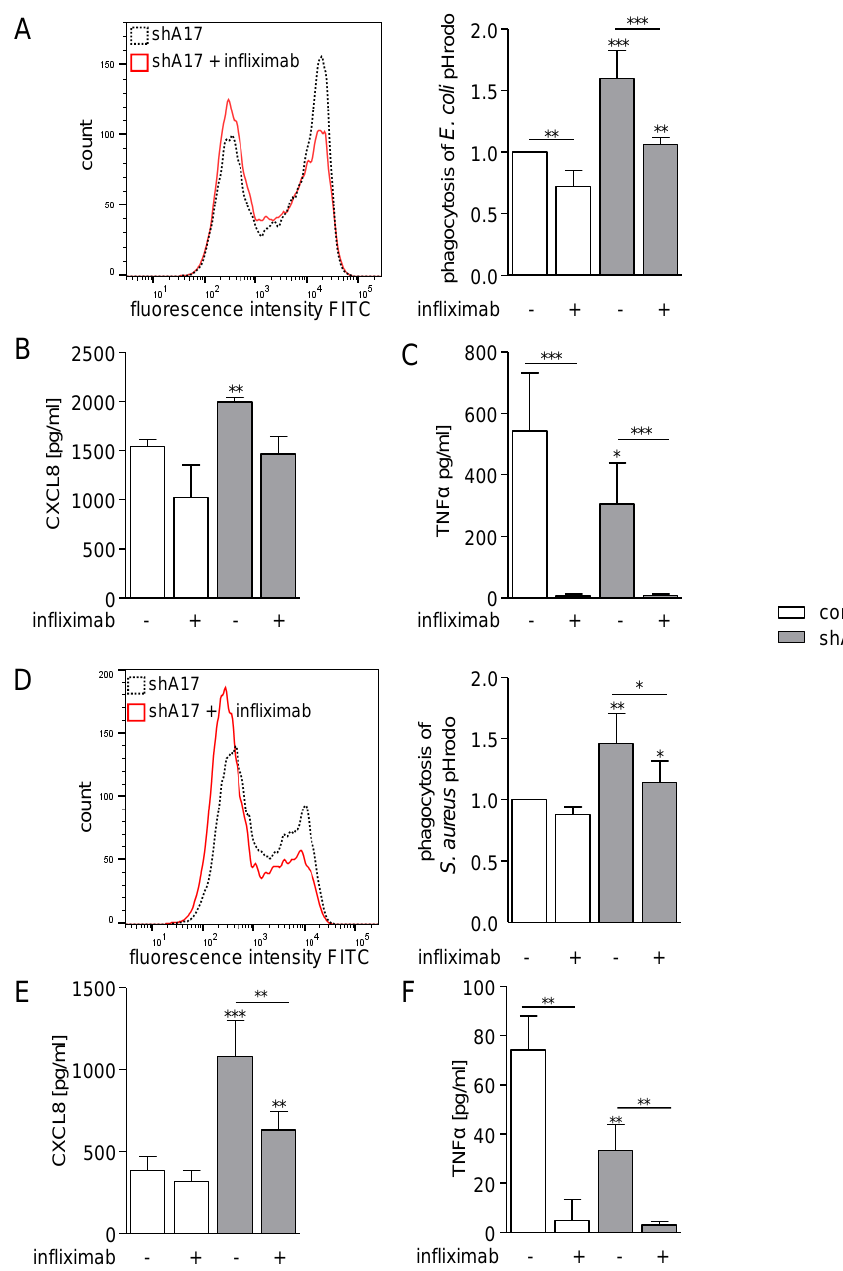
Figure 6. Inhibition of TNFα diminishes phagocytosis and CXCL8 release, ( A–F ) THP-1 cells were transduced with lentivirus encoding control–shRNA (control) or ADAM17–shRNA (shA17) and preincubated with 10 µg/mL infliximab or vehicle control. Subsequently, the transduced cells were incubated with E. coli ( A–C ) or S. aureus pHrodo green ( D–F ) and assayed for phagocytosis by flow cytometry ( A , D ) and for CXCL8 ( B , E ) and TNFα ( C , F ) release by ELISA. The geometric mean fluorescence of the cells was calculated in relation to that of the indicated control. Data are shown as mean and SD or representative histogram of at least three independent experiments ( A , D ) n = 5; ( B , C , E , F ) n = 3. Significant differences compared to the respective control are indicated as asterisks (* p < 0.05, ** p < 0.01, *** p < 0.001) and additional comparisons are specified by bars.